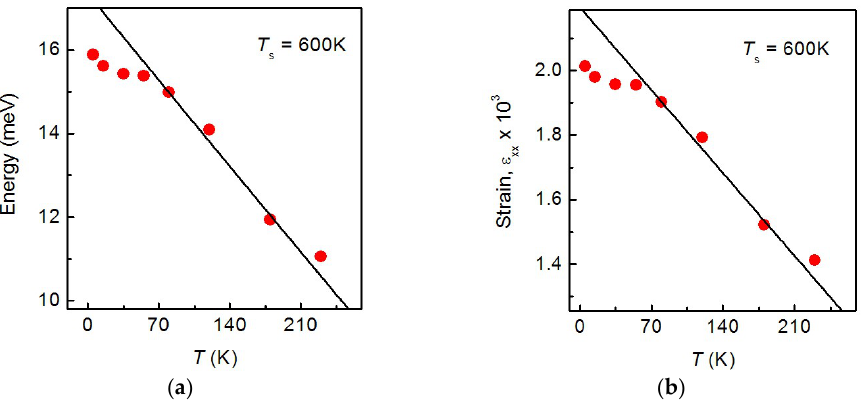
Figure A1. ( a ) Temperature dependence of light and heavy hole sub-bands splitting. Red dots are PL data, and the black line is calculations by formula (A13). ( b ) The calculated residual strain value of the GaAs layer as a function of temperature. The black line shows the dependence calculated by Formula (4), and the red dots show the dependence calculated using the values of the energy splitting of hole sub-bands taken from the PL data. All dependences are presented for the substrate temperature at which complete strain relaxation in GaAs occurs; T S = 600 K.